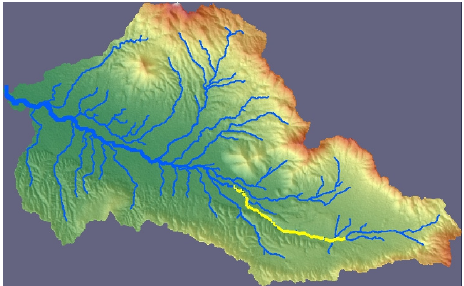
Figure 7. Definition of the study area’s limits.